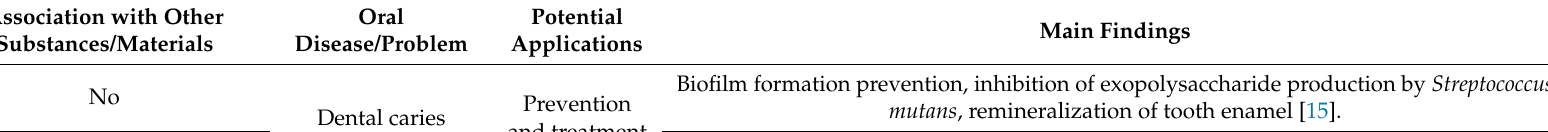
Table 1. Summary of the main findings of this